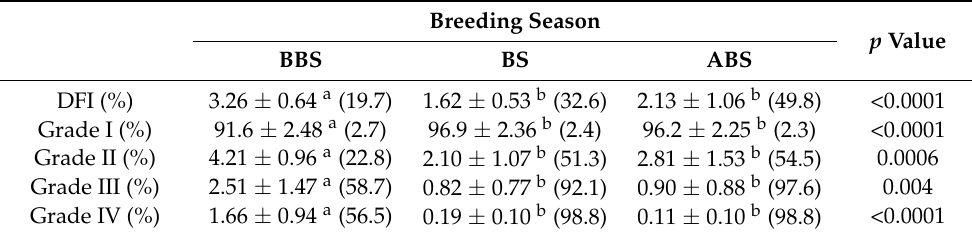
Table 3. The measures (mean ± SD (CV%)) of advanced semen evaluation tests, sperm chromatin dispersion test (SCD) and motile sperm organelle morphology examination (MSOME), in the selected periods of routine ram examination in the herd, before the breeding season (BBS), during the breeding season (BS), and after the breeding season (ABS).